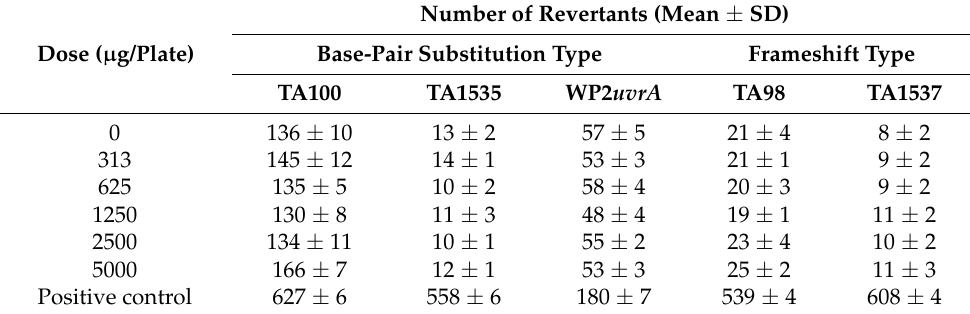
Values are mean ± SD of 3 plates. Dose 0-negative control: 100 µ L pure water; Positive control: for TA100 and TA1535,